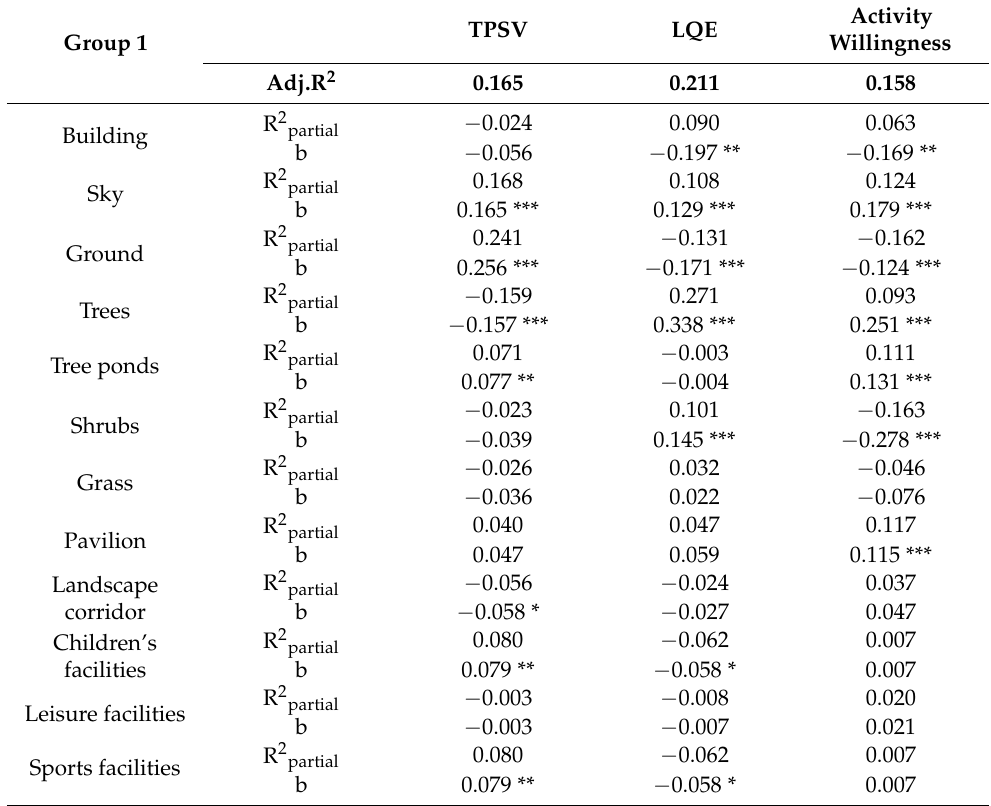
Table 9. Regression coefficients (%) of landscape parameters with TSPV from Group 1